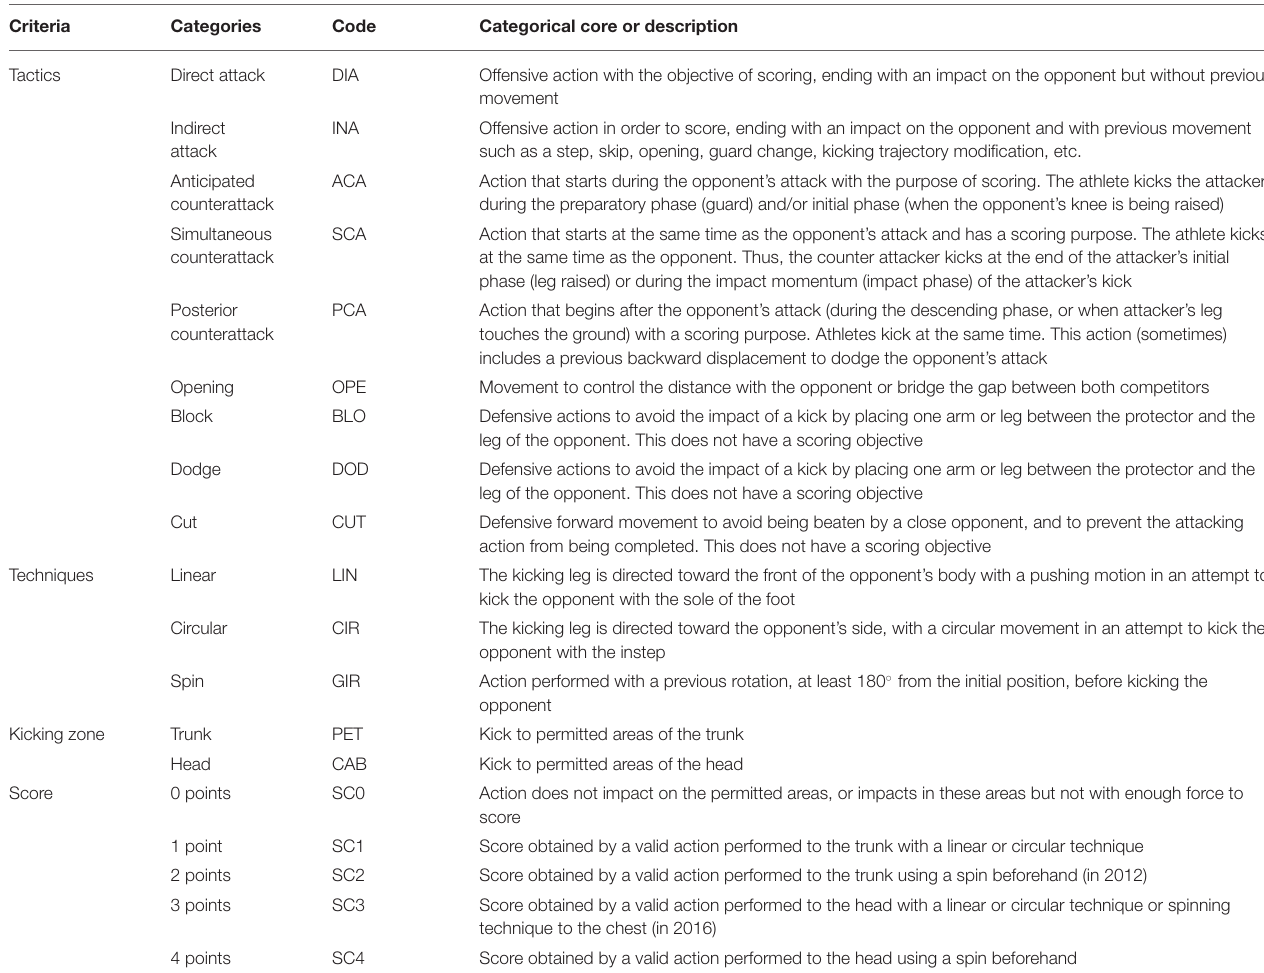
TABLE 1 | Categories, codes, and categorical core of the observational tool used.